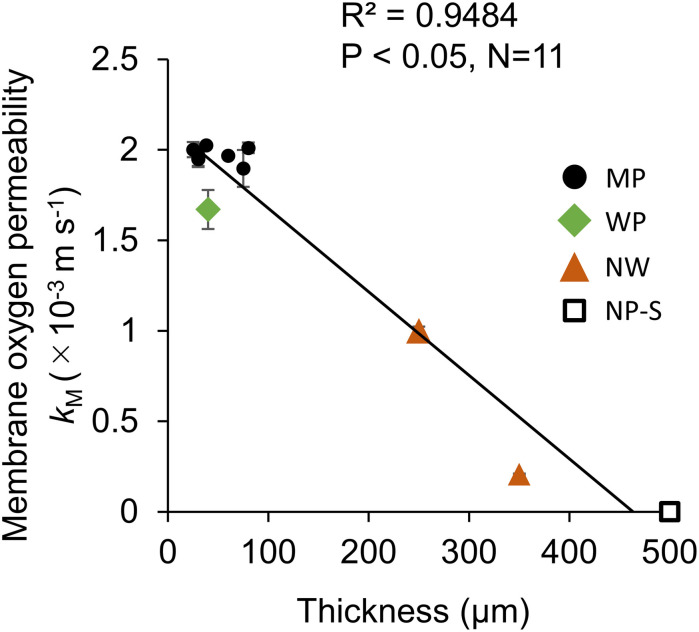
The relationship between oxygen transfer coefficient at the membrane (kM) and membrane thickness in the Air-Air permeation test. N = 3 for all the 11 films measured in this study. The error bar shows the standard deviation. MP: microporous; WP: woven porous; NW: microporous with a non-woven fabric; and NP-S: silicone films.